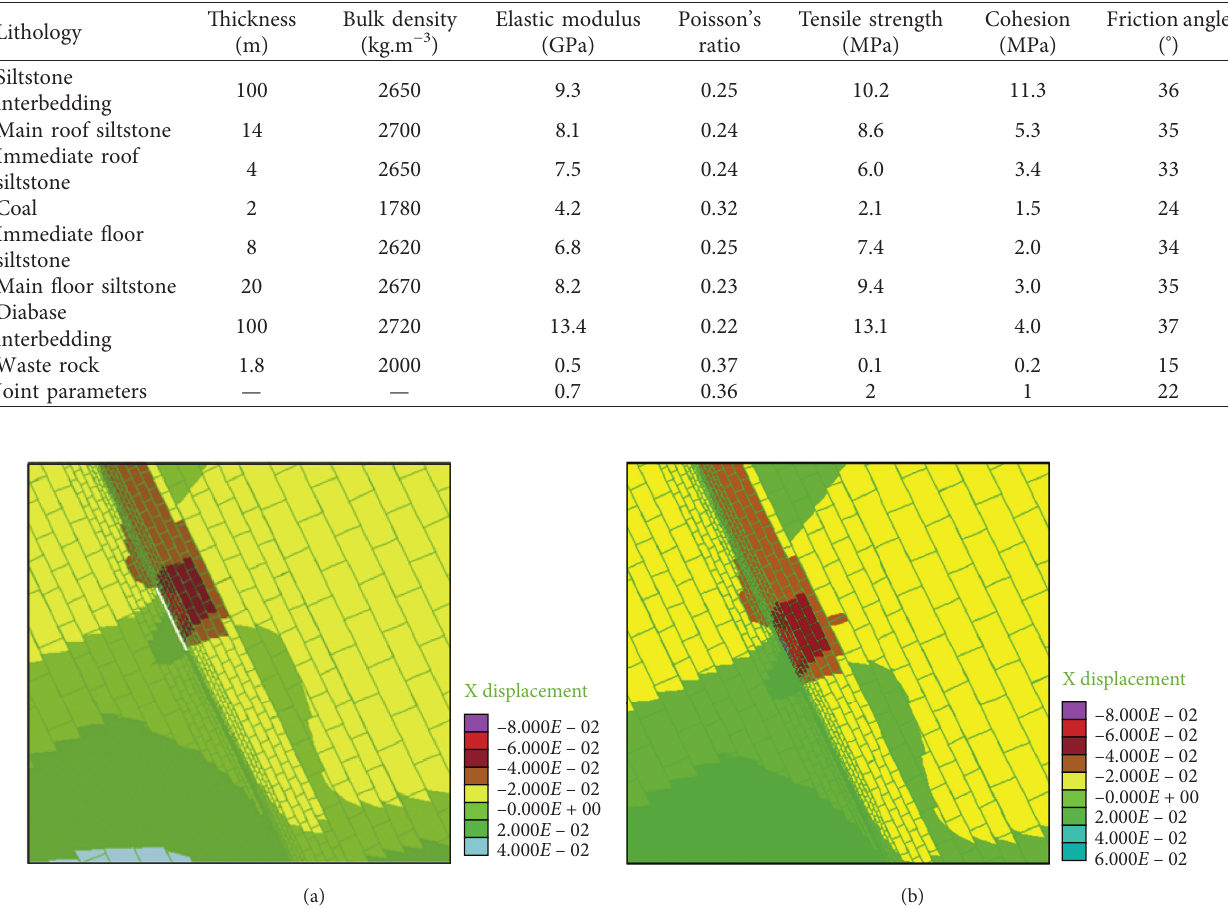
Figure 3: Horizontal displacement contours of surrounding rock with 40m stope height. (a) Caving. (b) Backfilling.